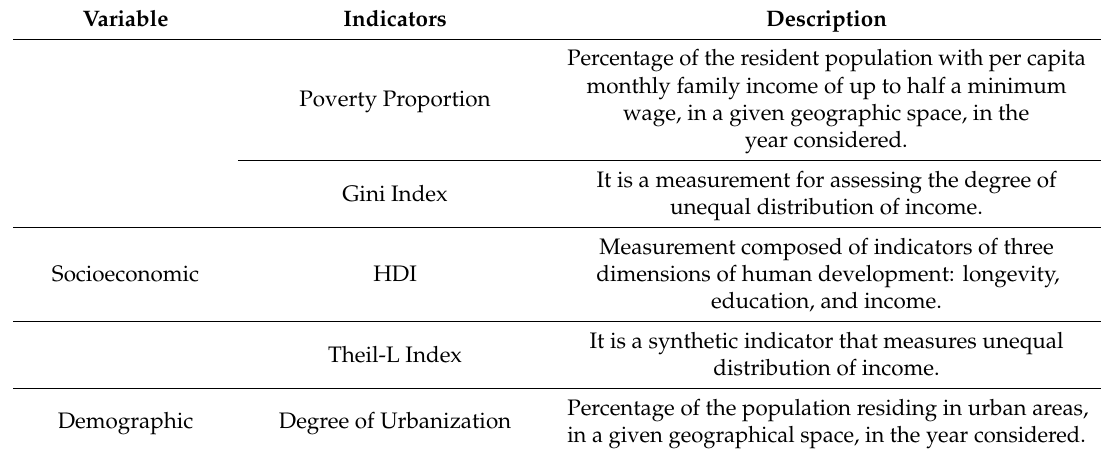
Table 1. Explanatory variables, indicators and